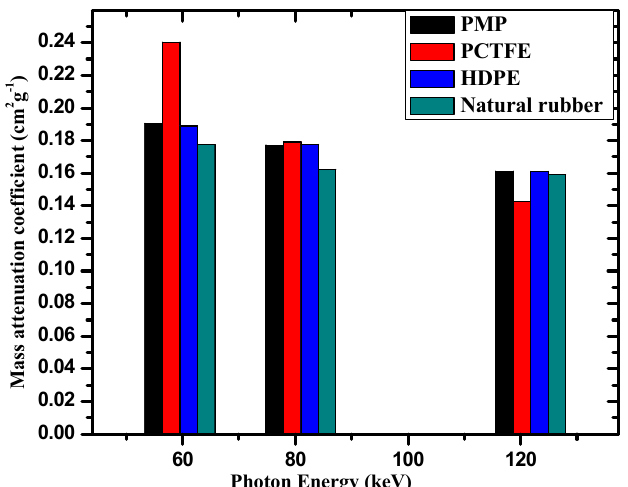
Figure 12. Mass attenuation coefficients of PMP and PCTFE polymers compared to other discussed experimental values of HDPE and natural rubbers.